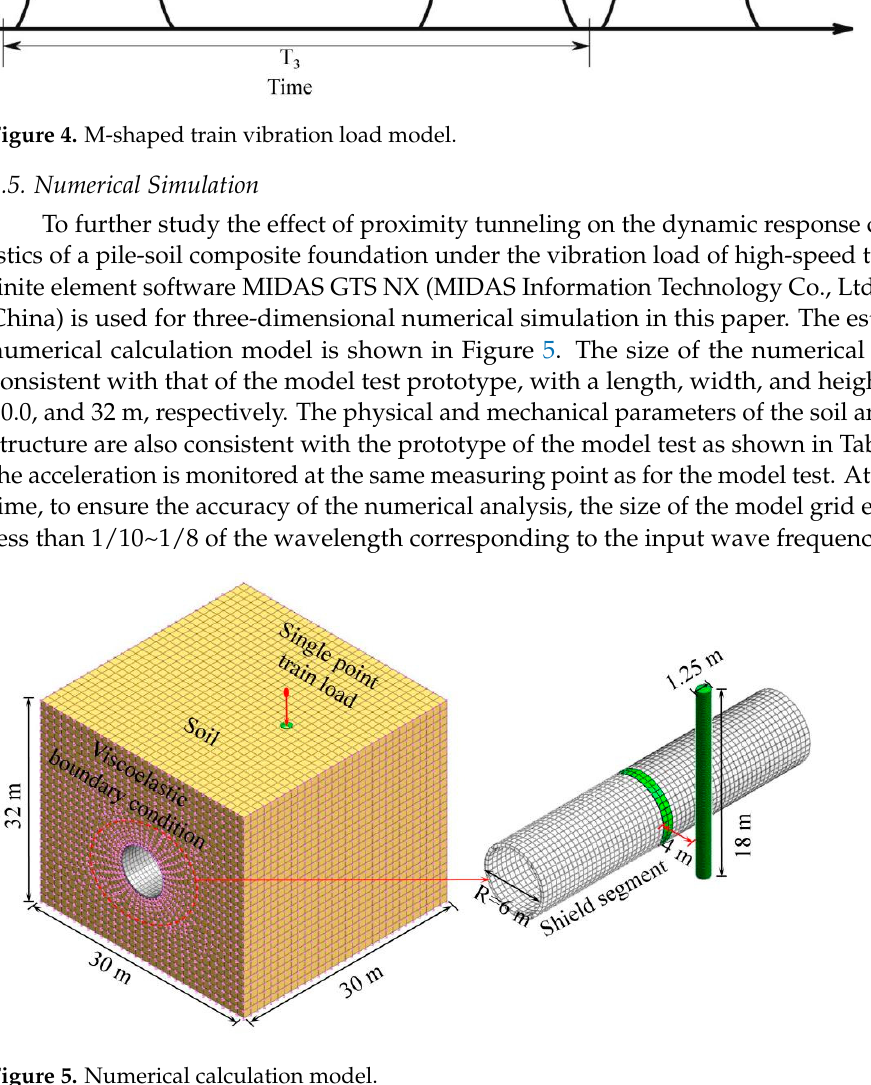
Figure 4. M-shaped train vibration load model.